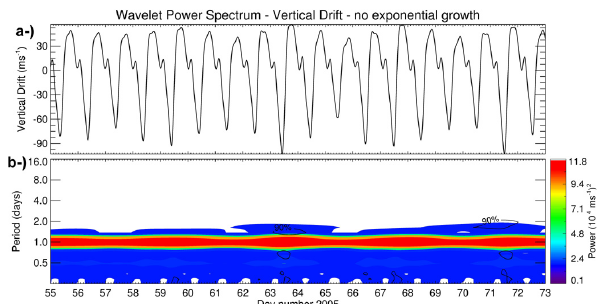
Fig. 4. (a) vertical drift calculated for the case where the UFK wave propagated upwards with 75% attenuation. (b) wavelet power spec- trum.